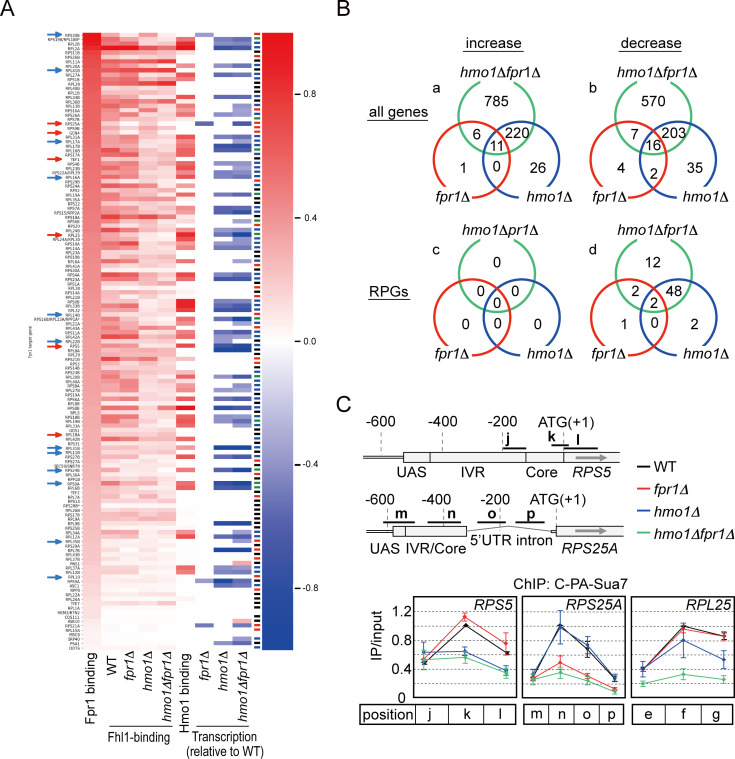
Effect of HMO1 and/or FPR1 deletion on transcription.(A) RNA levels of Fpr1-target genes were determined by RNA-seq analyses; the calculated ratios relative to WT were arranged in descending order of Fpr1-binding values and are shown as a heatmap, together with the ChIP-seq results for Fhl1. The Hmo1-binding results are ChIP-seq data quoted from Reja et al. [30]. Coloured symbols in the heatmap indicate that Fhl1 binding to each RPG is not influenced by deletion of HMO1 and FPR1 (black); is influenced by deletion of FPR1, but not by that of HMO1 (red); is influenced by deletion of HMO1, but not by that of FPR1 (red); or is influenced by deletion of both HMO1 and FPR1 (green), as indicated in S3 Fig. The red and blue arrows on the left indicate the RPGs that were individually examined using ChIP assays, shown in Fig 3B and S4 Fig, respectively. (B) Venn diagrams of genes whose transcription was decreased or increased by HMO1 and/or FPR1 deletion. Upper and lower Venn diagrams: genes in the entire genome and RPGs, respectively. The numbers of genes corresponding to each sector identified using RNA-seq are indicated. (C) Effect of HMO1 and/or FPR1 deletion on PIC assembly on specific RPG promoters, examined using ChIP assays in WT, fpr1Δ, hmo1Δ, and hmo1Δfpr1Δ cells expressing C-terminally PA-tagged Sua7 (YKK1115, YKK1117, YKK1119, and YKK1121, respectively). Schematic diagrams: promoters of RPS5 and RPS25A; j–l (RPS5) and m–p (RPS25A): regions amplified by PCR in the ChIP assay. A schematic representation of the RPL25 promoter indicating the regions amplified by PCR is depicted in Fig 2A (e, f, g). Values obtained from ChIP assays were expressed as ratios to the top value of WT cells and are shown as line graphs.